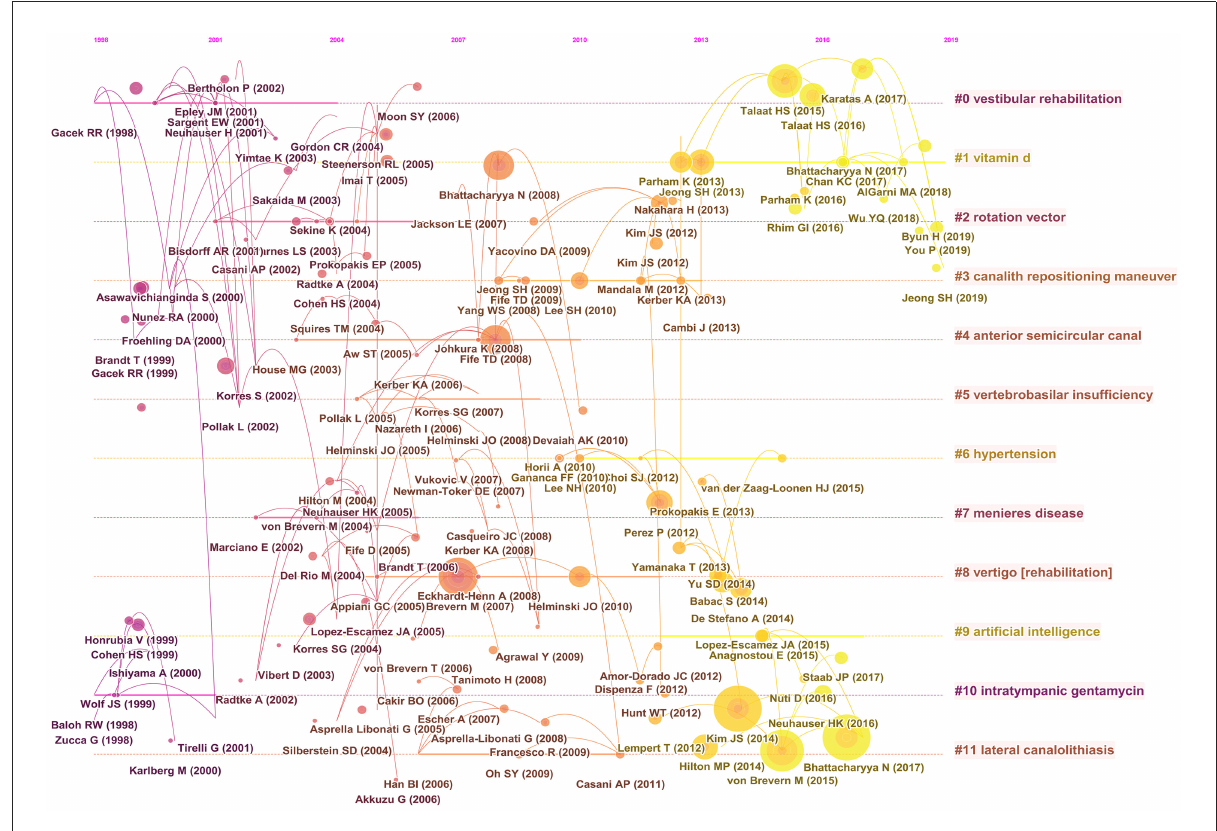
FIGURE7 Timelines of the co-cited references with cluster